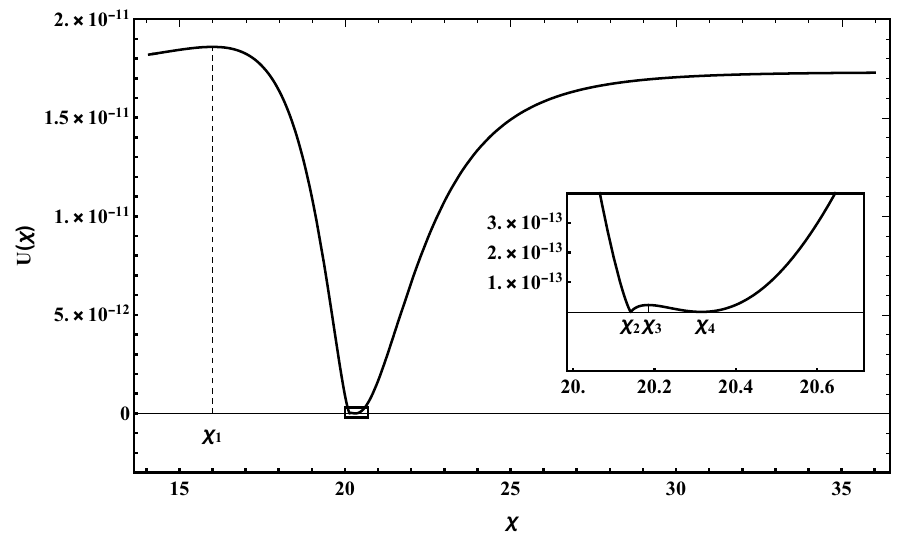
Figure 1 . The potential for the canonical Einstein frame in(cid:13)aton, (cid:31) . The lopsided form of the potential becomes enhanced and is no longer symmetric around (cid:31) = (cid:31) 3 (which corresponds to (cid:30) = (cid:22)= 2 in the Jordan frame potential). The region (cid:31) > (cid:31) 4 , corresponding to region (cid:30) > (cid:22) , (cid:13)attened further and suitable for PLANCK 2018 compatible in(cid:13)ation. One can also in(cid:13)ate in the region (cid:31) 2 < (cid:31) < (cid:31) 3 , but not for all values of (cid:24) and (cid:22)